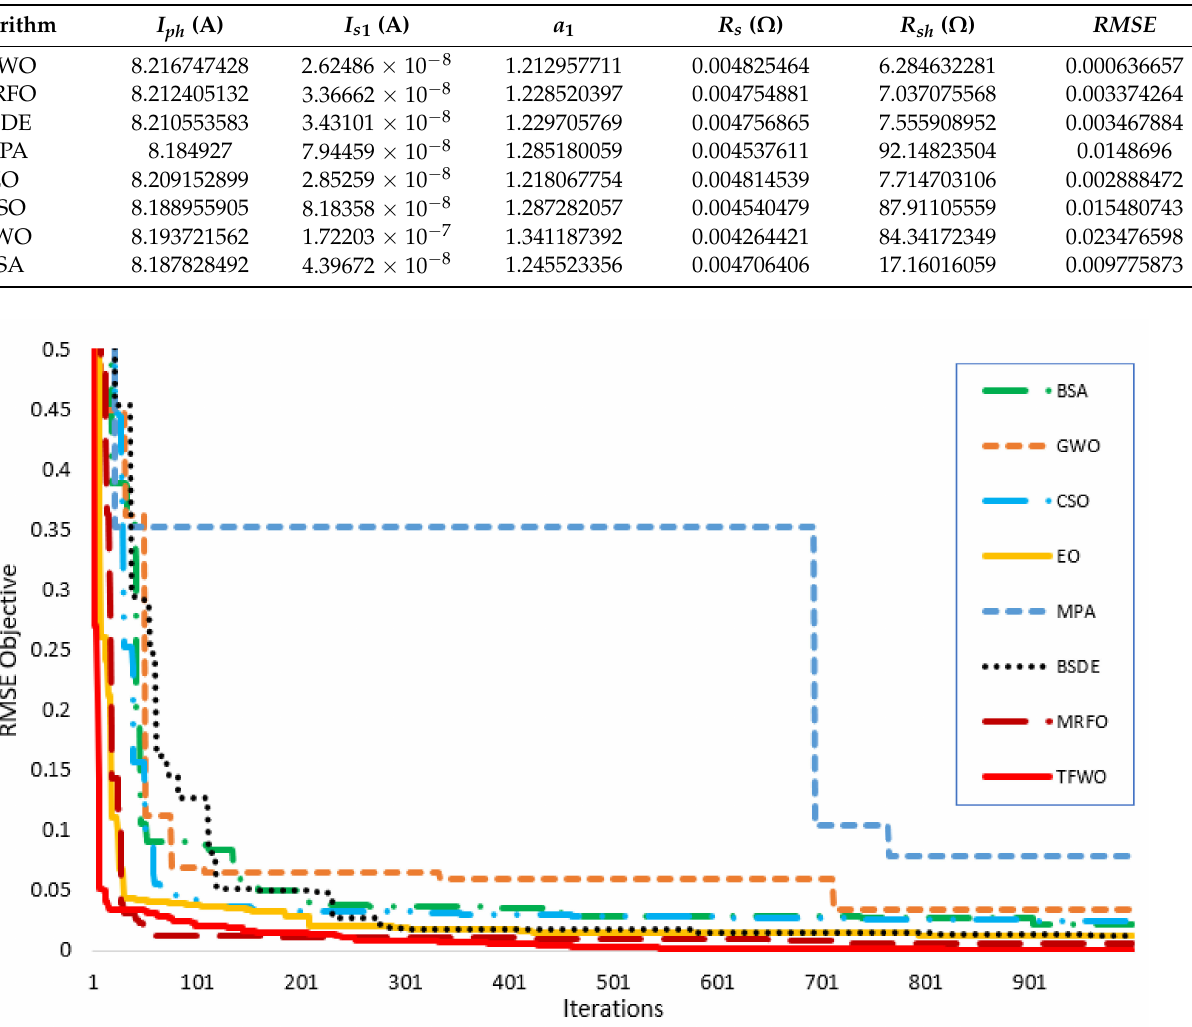
Figure 17. The convergence curves for KC200GT